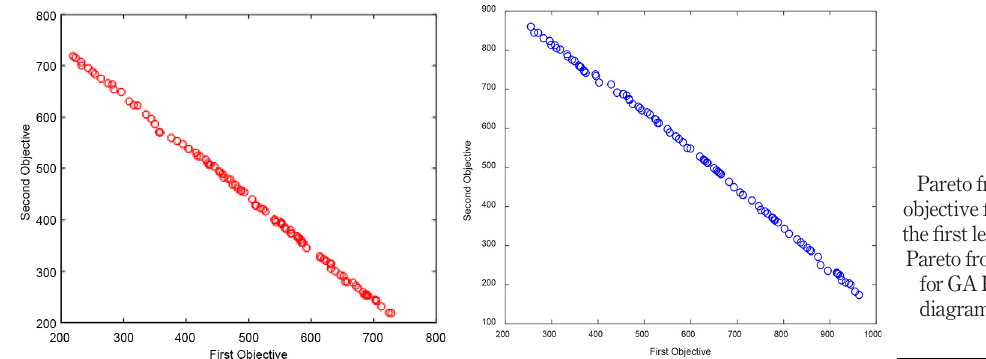
Figure 3. Pareto front for two objective functions in the fi rst level of mode Pareto front diagram for GA Pareto front diagram for